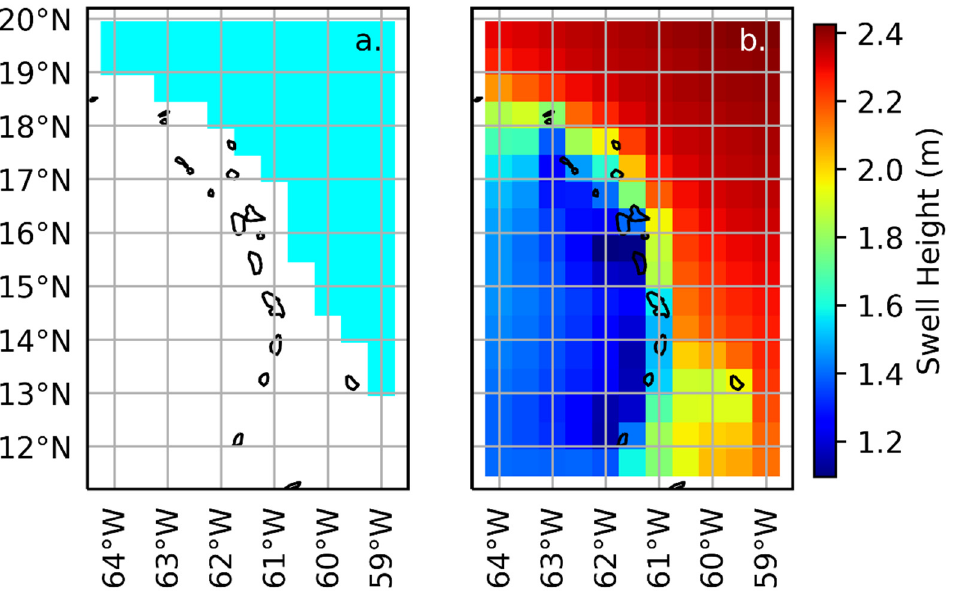
Figure 2. ( a ). Masked (white) and selected (turquoise) 0.5° × 0.5° cells for the eastern Caribbean study area. Selected cells have height ≥ 2.2 m in b. ( b ). 90th percentile values of swell height over study period.